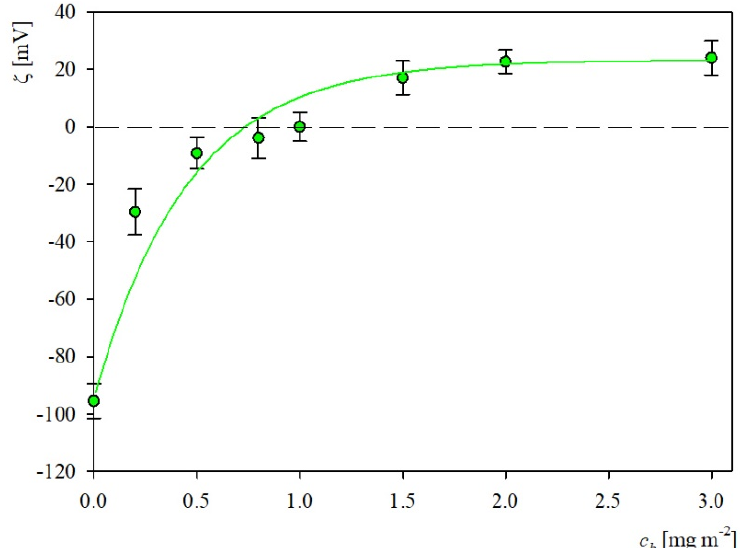
Figure 9. The dependence of the zeta potential of negatively charged polymer particles (S800) on the bulk S1R at protein concentration; adsorption conditions: pH 3.5, 10 mM NaCl, particle concentration 50 mg L − 1 . The points denote experimental results obtained from the LDV measurements; the solid lines show the theoretical results calculated from the electrokinetic model, Equation (2).